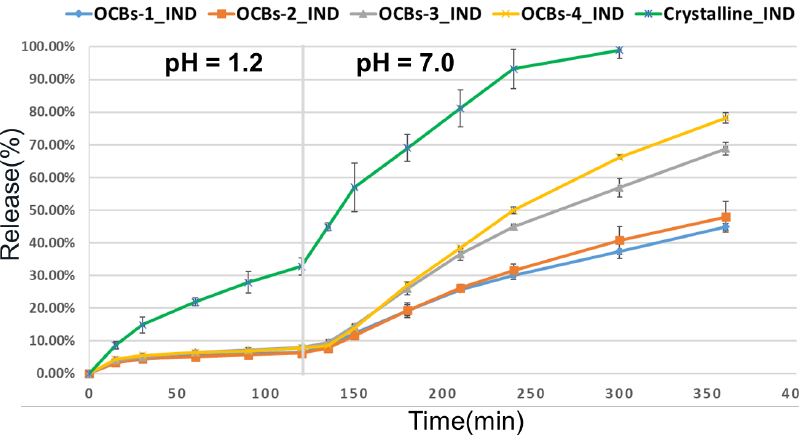
Figure 7. Release profiles of IND from OCBs in different pHs. The depicted results are mean ± SD, n = 3.